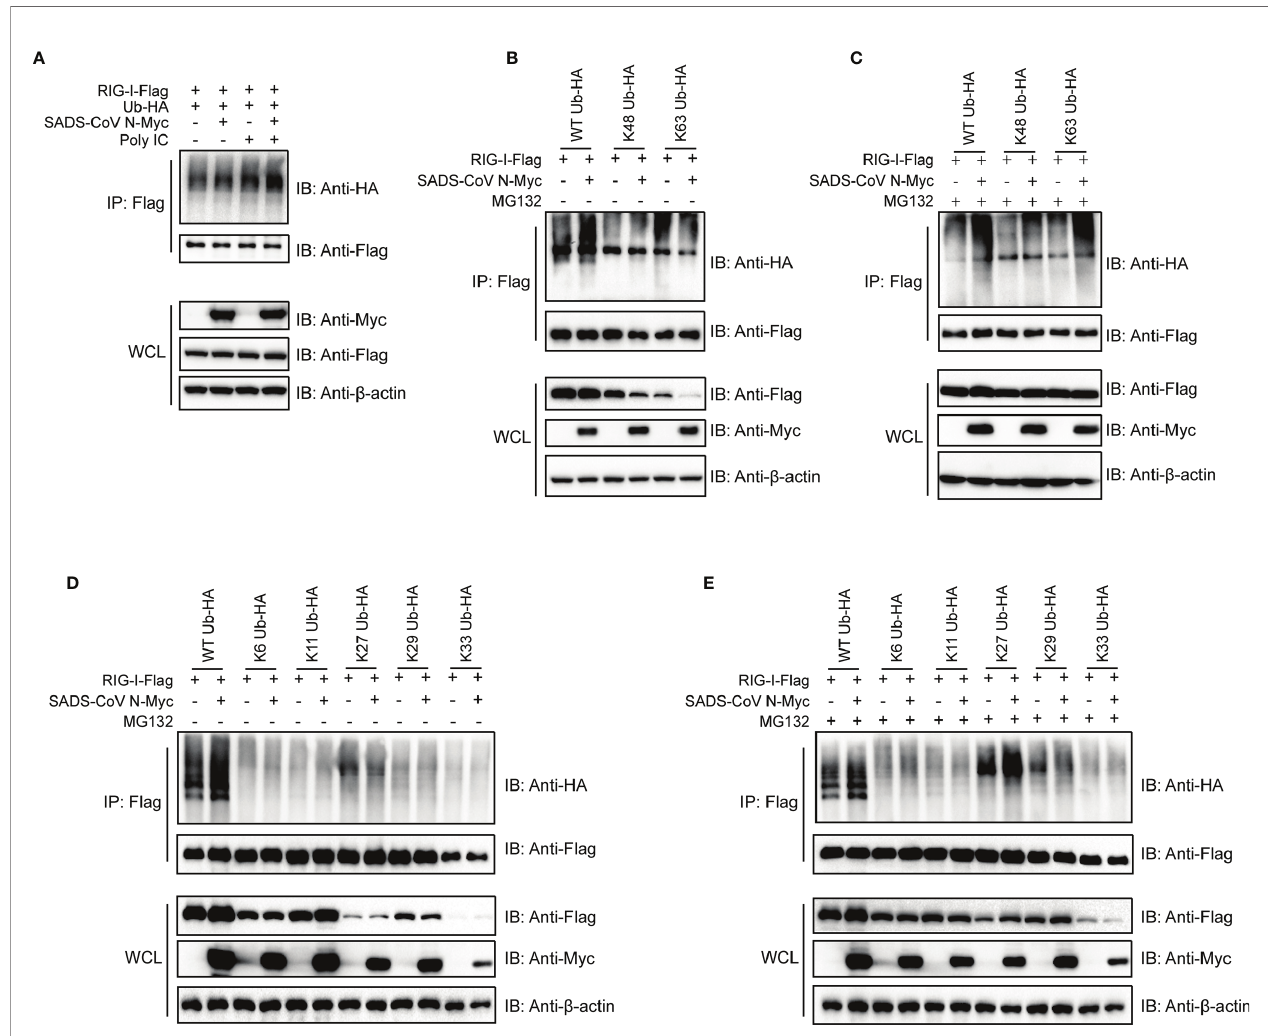
FIGURE 5 | The SADS-CoV N protein induces ubiquitination of RIG-I and mediates proteasomal degradation of polyubiquitin-linked RIG-I. (A) HA-tagged wild type ubiquitin, fl ag-tagged full-length RIG-I and empty vector or SADS-CoV N were coexpressed in 293T cells. RIG-I signaling was activated by transfection with poly(I:C), and ubiquitination of RIG-I was measured by detection of HA-tags in immunoprecipitation products using anti- fl ag antibodies at 36 h post-transfection (hpt). (B, C) Flag-tagged full length RIG-I and empty vector or SADS-CoV N protein were coexpressed in 293T cells, along with HA-tagged wild type, K63- or K48- ubiquitin with (B) or without (C) 10 m M of MG132 treatment at 4 hpi until measurement of RIG-I ubiquitination at 36 hpt. (D, E) Experiment was repeated as in (B, C) , except that K6-, K11-, K27-, K29-, K33-ubiquitin were